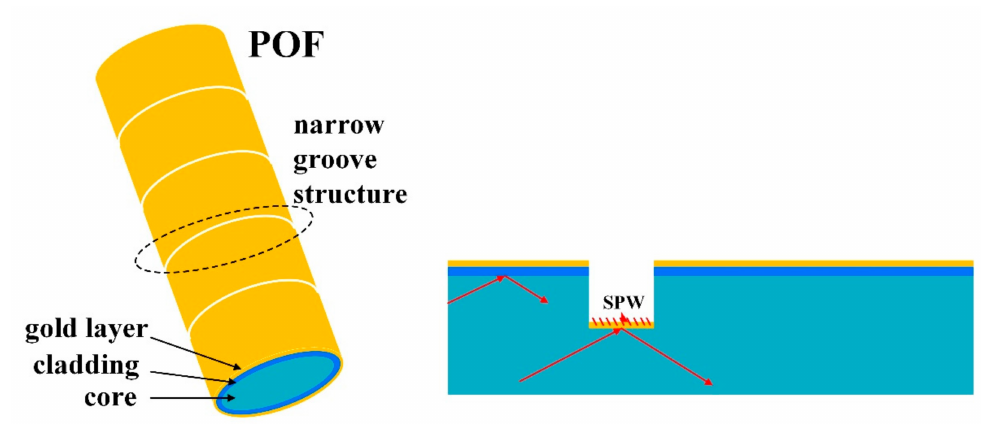
Figure 18. The schematic diagram of the narrow grooves structure, POF-based surface plasmon resonance sensor